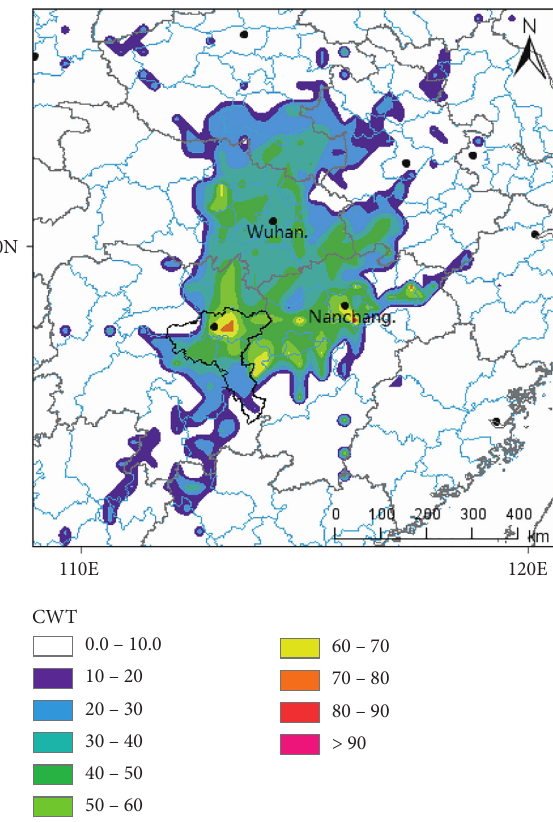
Figure 3: Contribution distribution of potential source areas of PM2.5 in winter of 2019 in Chang-Zhu-Tan region.